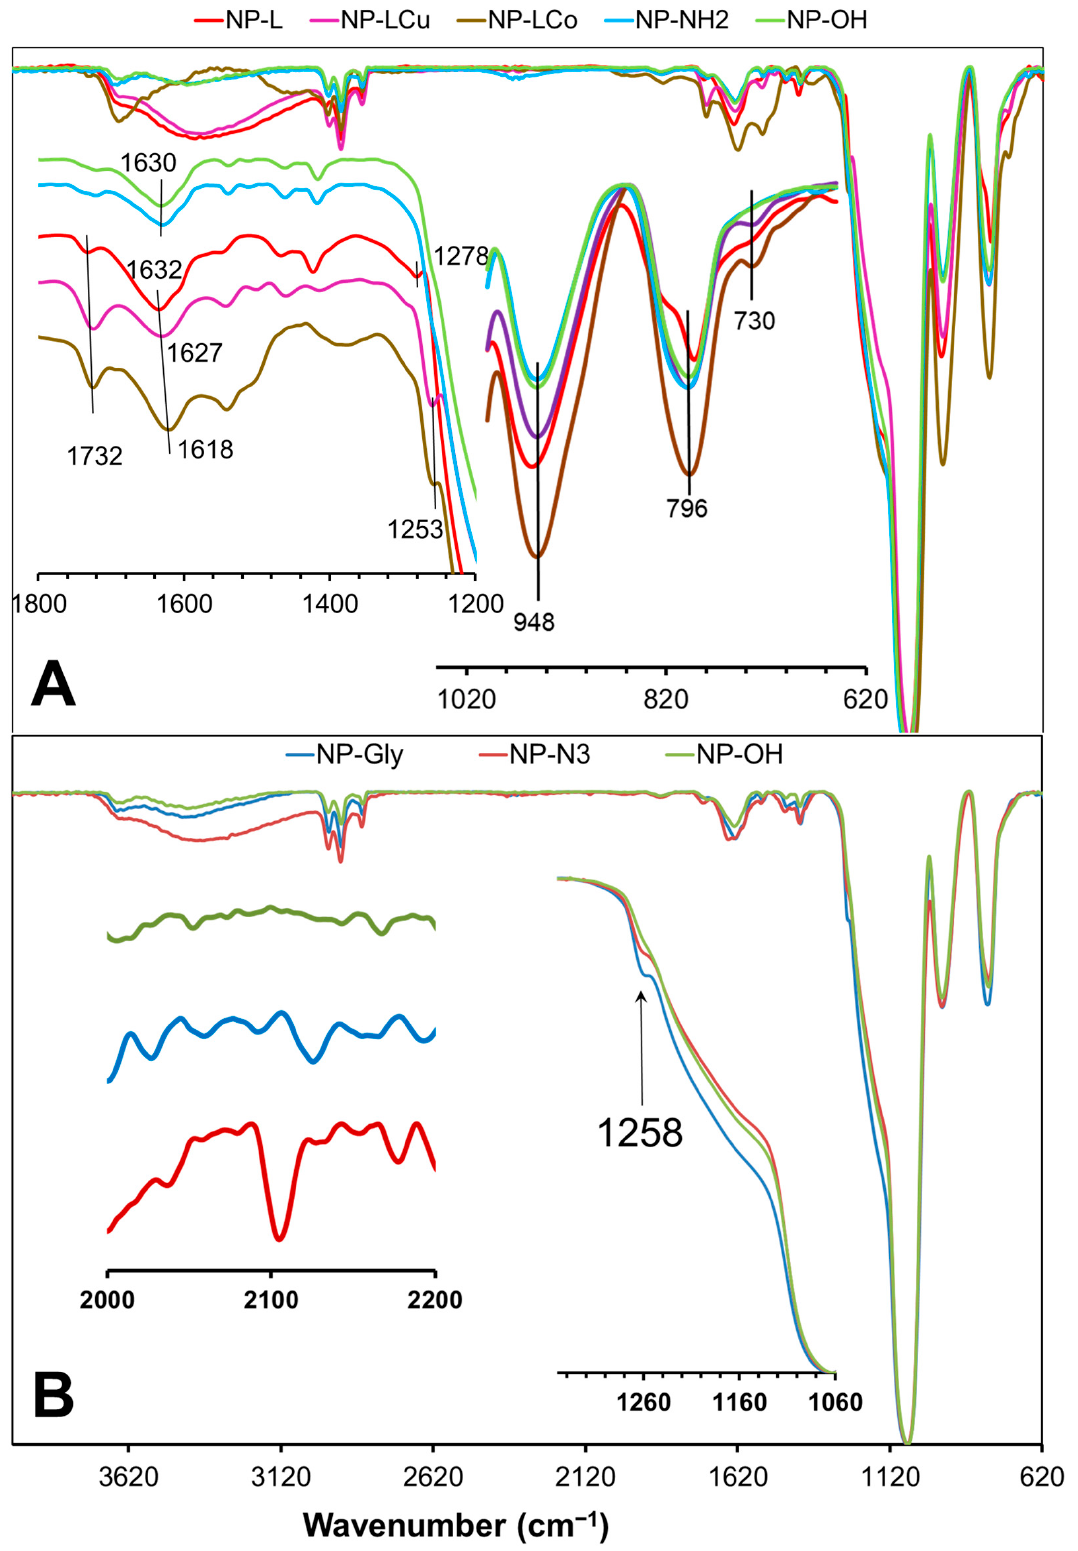
Figure 1. Normalized FTIR spectra of ( A ) Reaction 1: NP-OH (light green), NP-NH 2 (light blue) and modified NP-L (red), NP-LCu (violet) and NP-LCo (khaki); ( B ) Reaction 2: NP-OH (light green), NP-Gly (blue) and modified NP-N 3 (crimson). The insets show the offset of the normalized spectra in the regions of interest.